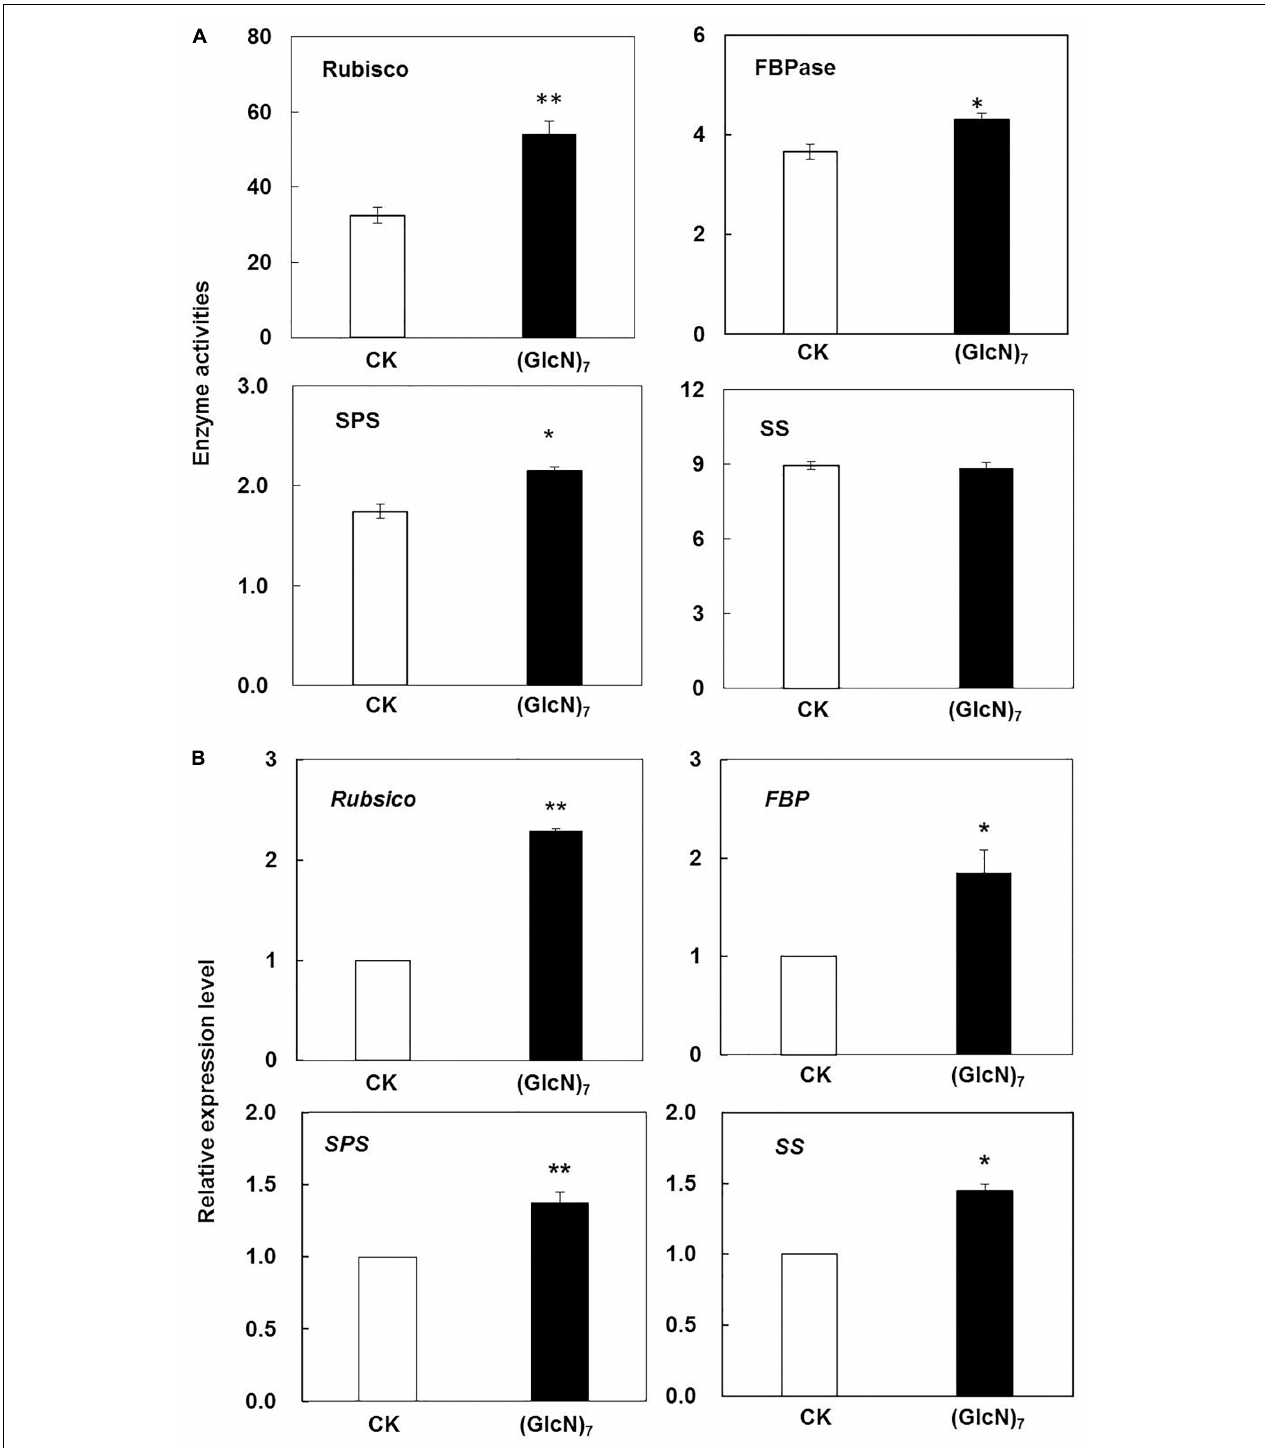
FIGURE 4 | Impacts of (GlcN) 7 on the photosynthetic C metabolism of wheat seedlings. (A) Key enzyme activities in photosynthetic C metabolism. Rubisco and FBPase activities are expressed as nmol s − 1 g − 1 fresh weight (FW), and SPS and SS activities are expressed as µ mol min − 1 g − 1 FW. (B) Relative expression level of key enzymes in photosynthetic C metbolism. Relative expression levels are calculated and normalized using β -actin as an internal control. Each value represents means ± SD calculated from four independent biological replicates. Significant differences from the CK are shown ( ∗ P < 0.05, ∗∗ P < 0.01; t -test).